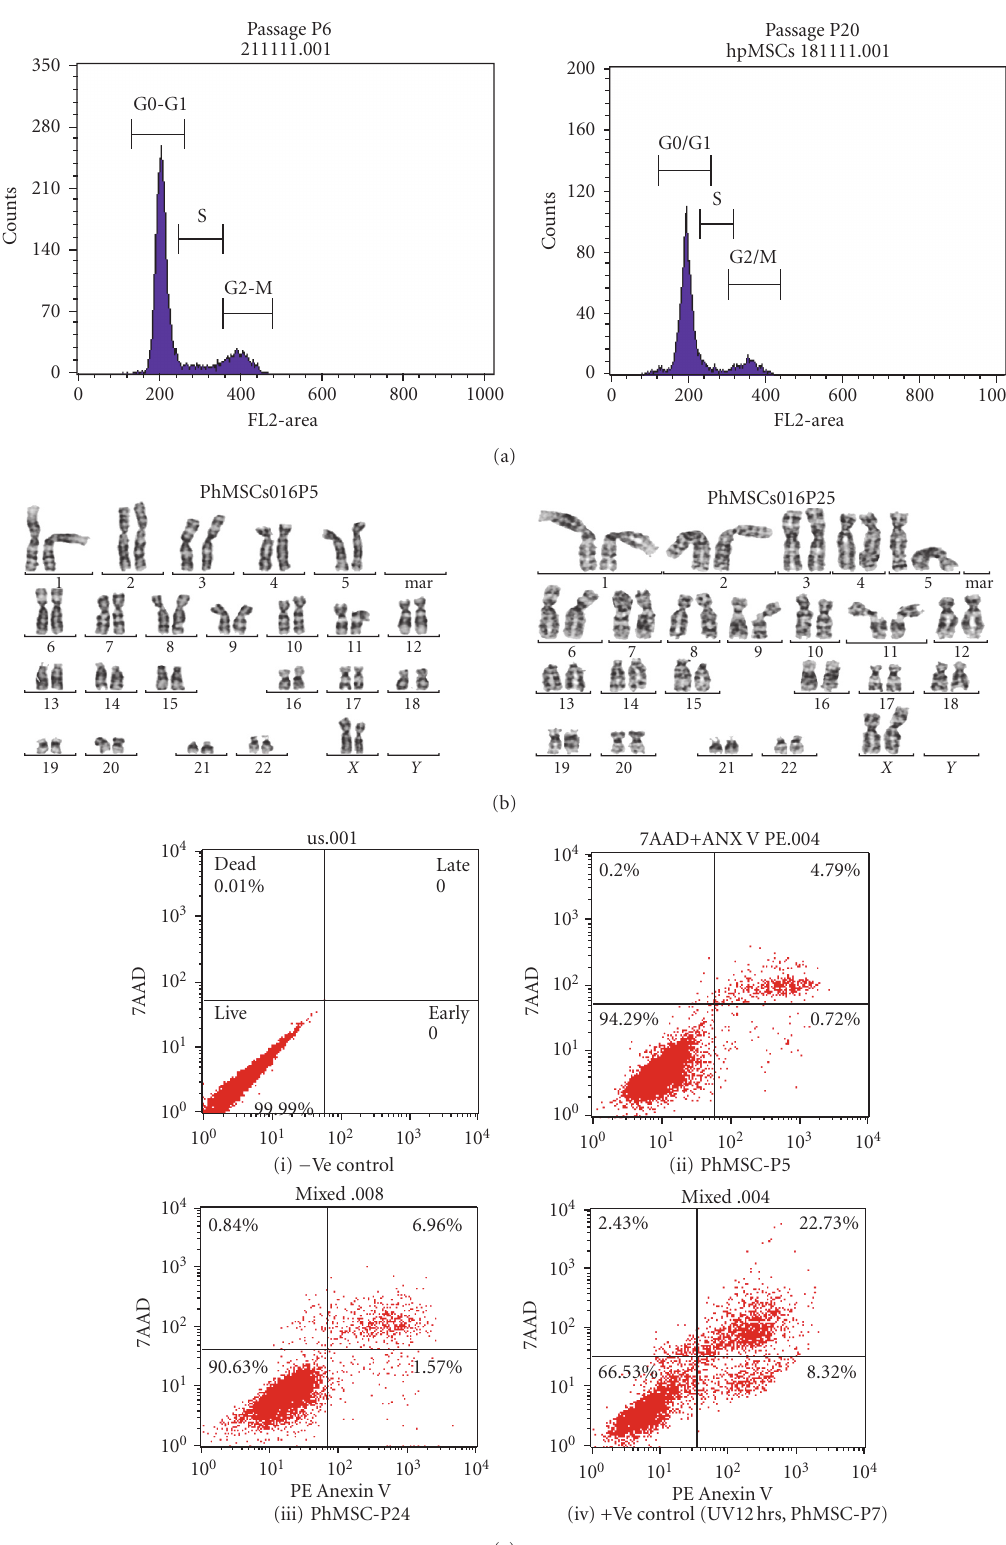
Figure 3: Cell cycle karyotype analysis: (a) cell cycle pattern of early (passage 5) and late passage (passage 20). PD-MSC were analyzed by FACS after propidim iodide staining. (b) Karyotype analysis was performed on early (passage 5) and late (passage25) passage MSC. (c) Apoptosis analysis was done by FACS using Annexin V and 7AAD. (i). negative control. (ii) Total % apoptotic MSC cells (Passage 5). (iii) % apoptotic cells (Passage 24) (iv).positive